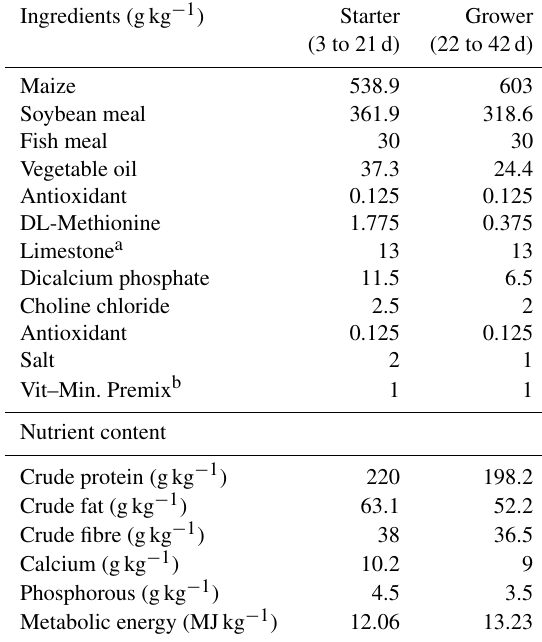
Table 1. Ingredients and nutrient composition of broiler starter and grower diets in the study (gkg − 1 ).